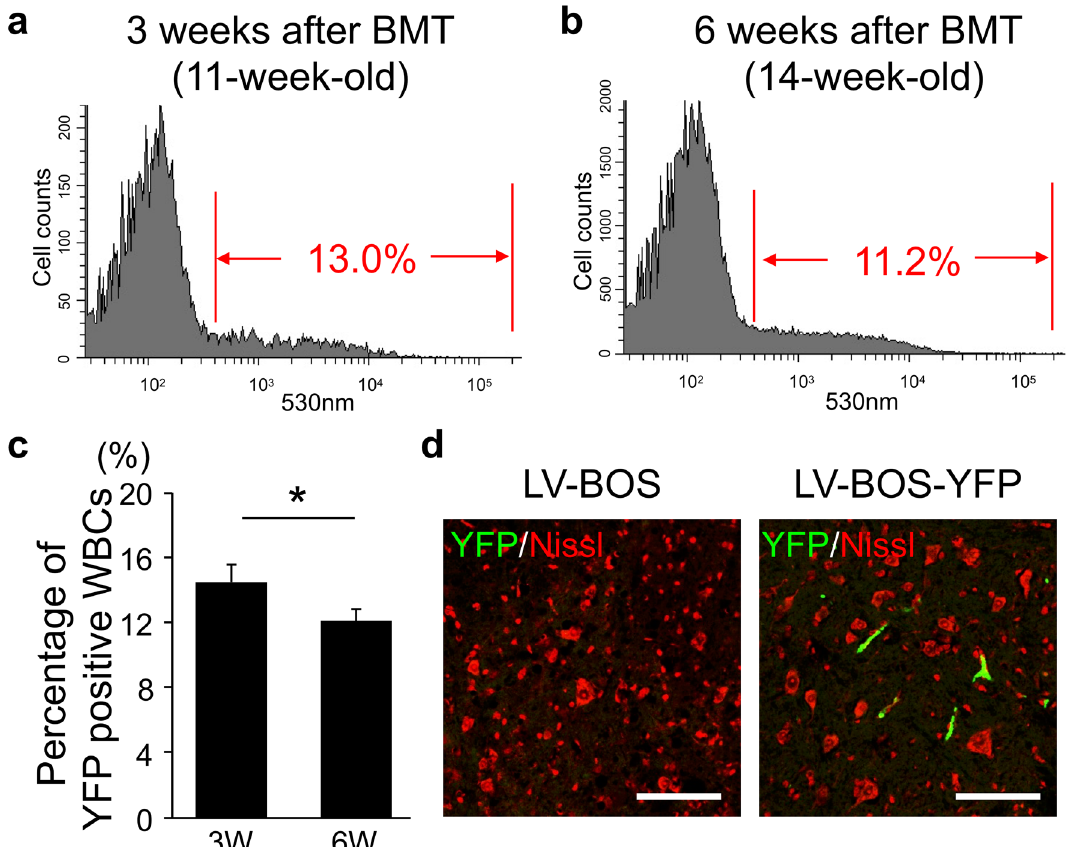
Figure 2. Transduction efficiency of bone marrow cells with LV-BOS-YFP in SOD1(G93A) mice. ( a , b ) Representative flow cytometric analysis of LV-BOS-YFP-mediated transduction in SOD1(G93A) mice at 3 weeks [( a ), 11-week-old] and 6 weeks [( b ), 14-week-old] after bone marrow transplantation. Red letters indicate the YFP-positive population in ( a ) and ( b ). ( c ) The percentage of YFP positive WBCs in total peripheral WBCs of 3 weeks and 6 weeks after bone marrow transplantation (n = 5, each group). ( d ) YFP signals (green) and Nissl stain (red) in ventral horn sections of the spinal cord at the lumbar level from SOD1(G93A) mice at 6 weeks after bone marrow transplantation with LV-BOS-YFP gene transduction. The left panel shows LV-BOS empty vector group and the right panel shows the LV-BOS-YFP vector group. Scale bar = 100 μm. Error bars represent the mean + SD. *p < 0.05. WBCs white blood